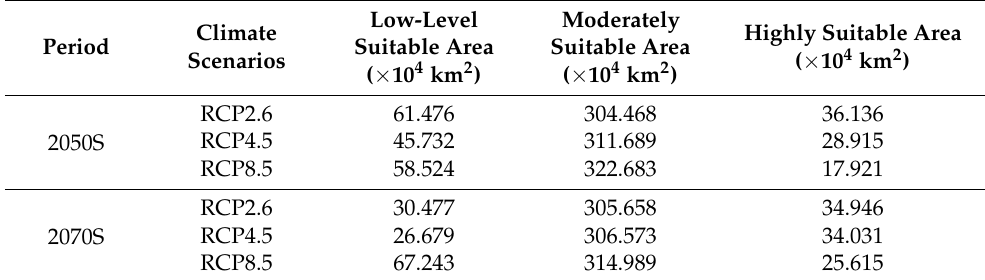
Table 5. Areas of potential distribution of Liriodendron tulipifera under different climate scenarios.